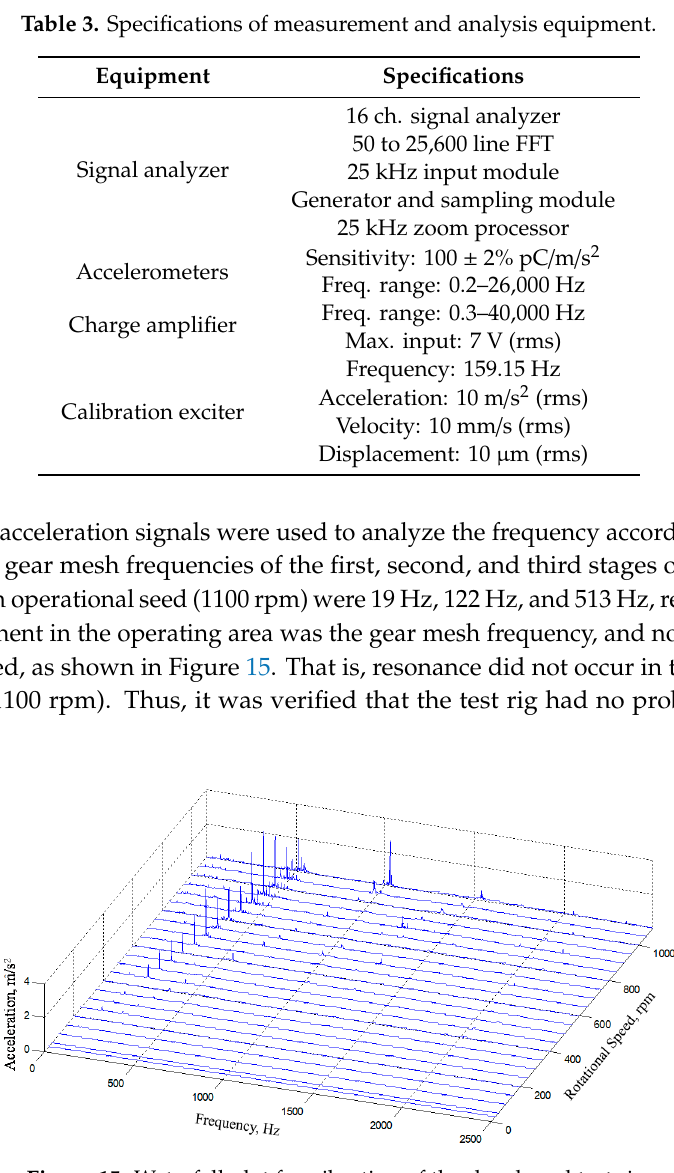
Figure 15. Waterfall plot for vibration of the developed test rig.